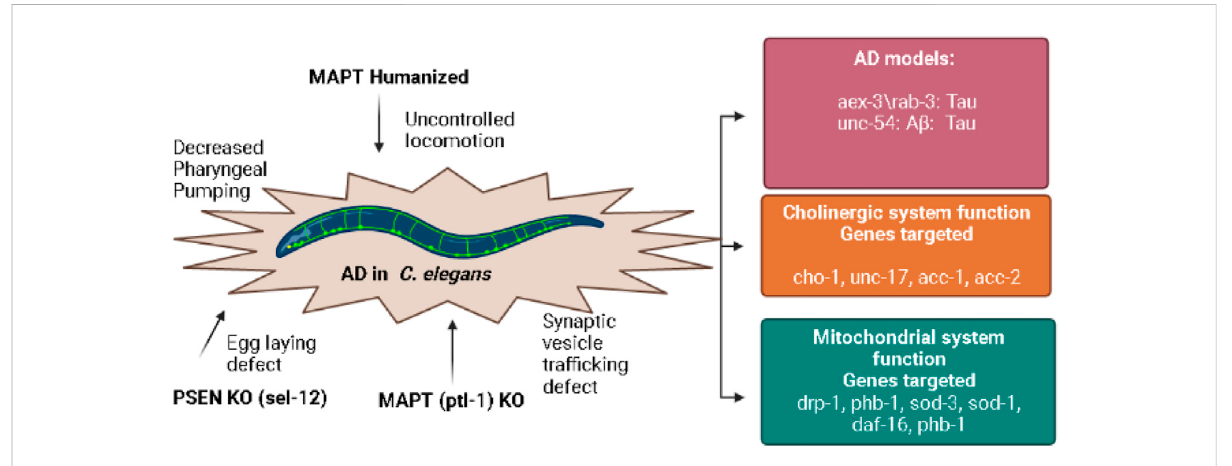
FIGURE 1 C. elegans models for Alzheimer ’ s disease by targeting different